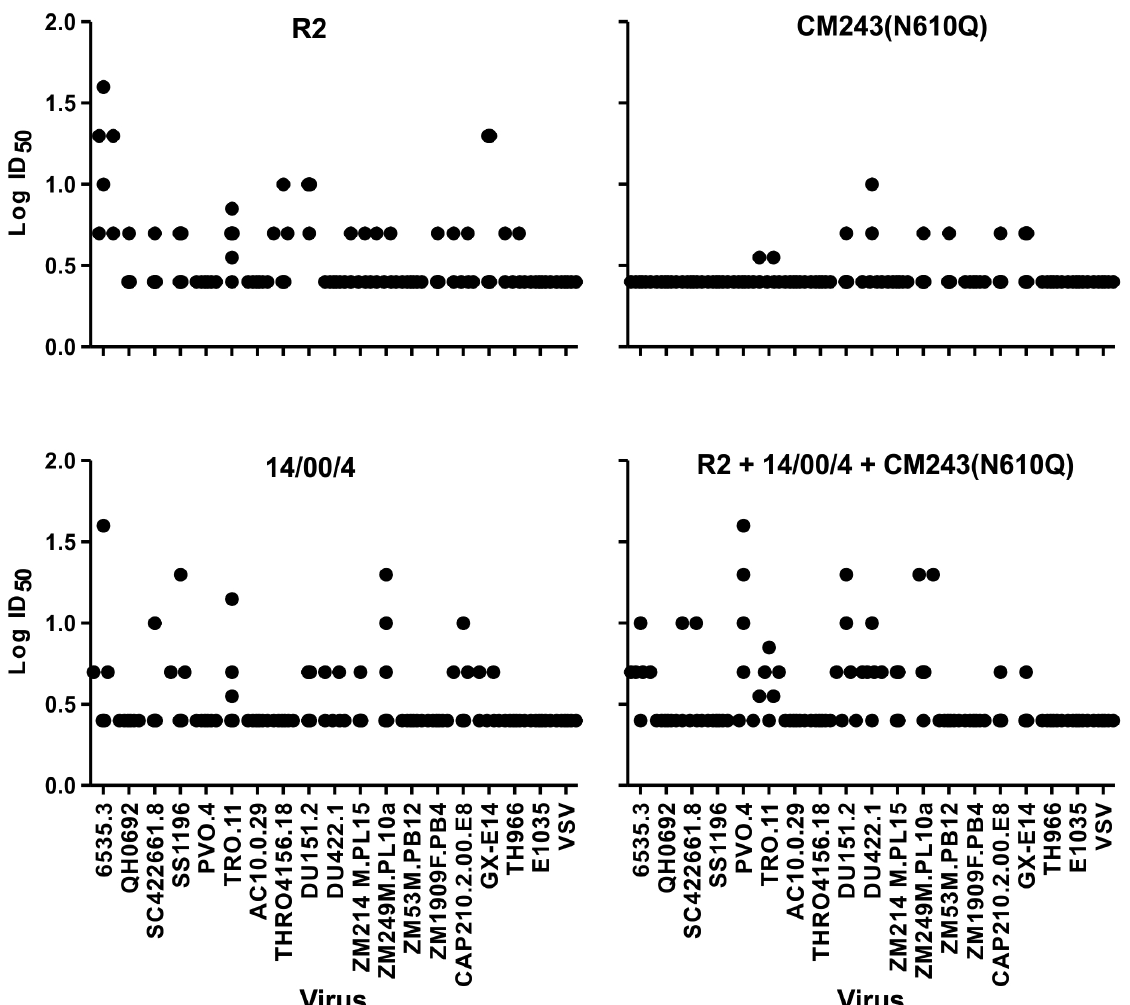
Figure 5. Neutralizing antibody responses of monkeys against viruses pseudotyped with subtype B, C, and A/E envelope glycoproteins. Sera were tested in serial dilutions starting at 1:5. Sera with less than 50% neutralizing activity at 1:5 were assigned inhibitory dilution 50% (ID 50 ) of 2.5 (log dilution=0.4). Dotted vertical lines indicate groupings of Clade B, C, and A/E pseudoviruses tested for neutralization.